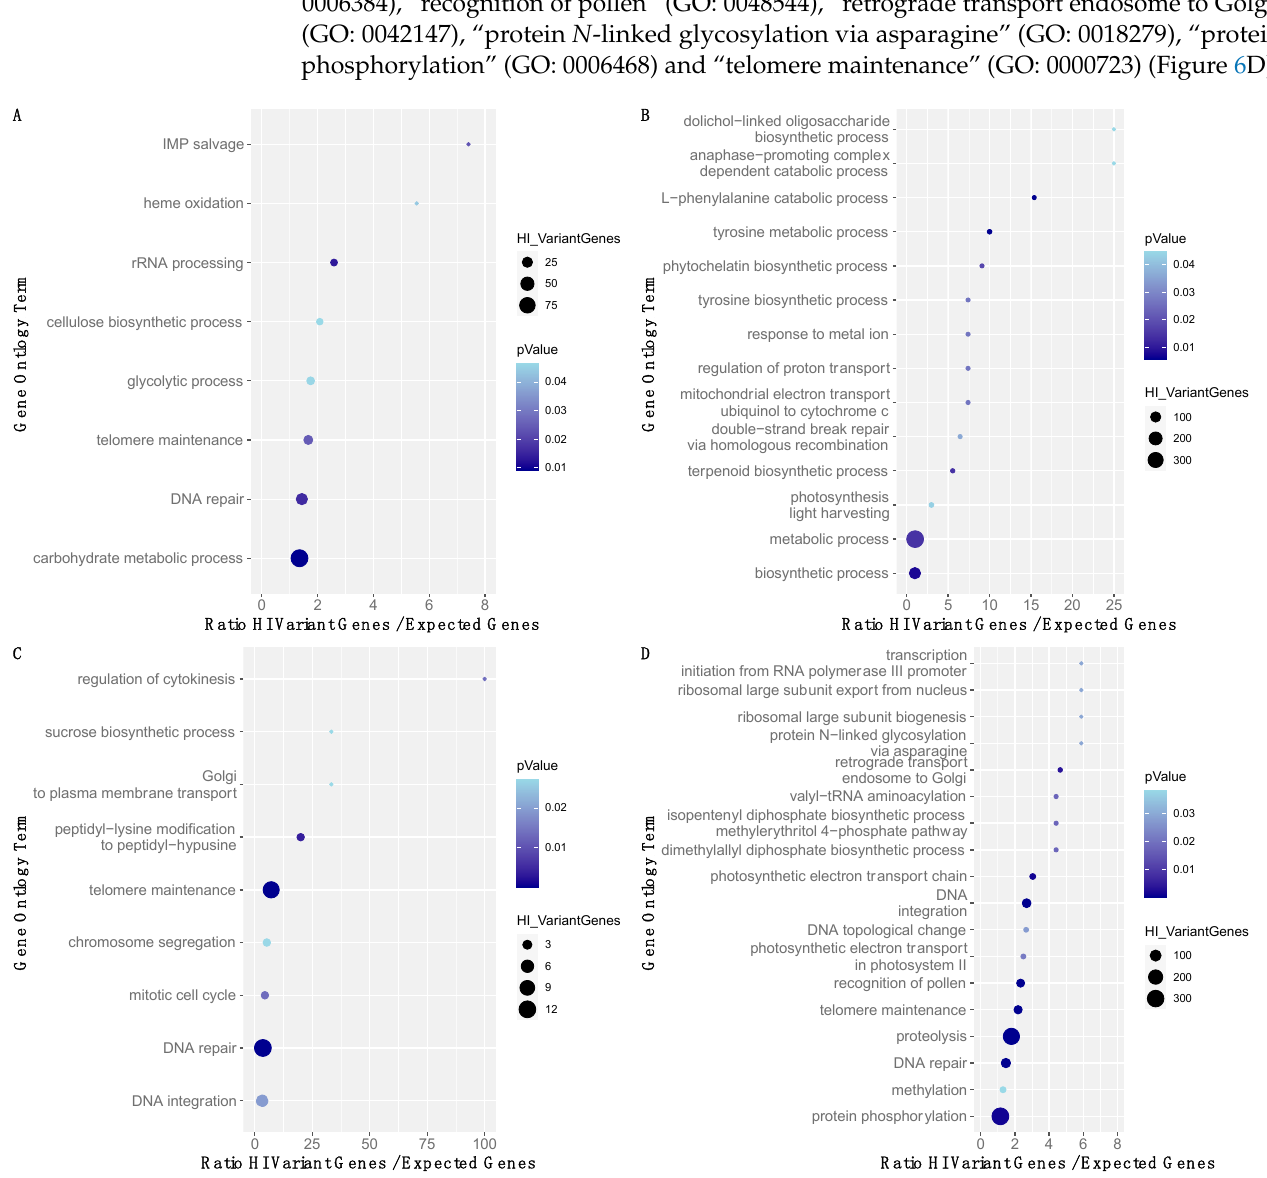
Figure 6. Gene Ontology analysis of the genes affected by high impact variants. The x-axis represents the value of the over or under-representation of these categories. The size of the dot represents the number of genes of the category and the color intensity its statistical significance as p -value. ( A ) Vouves bottom tree sample; ( B ) Vouves top tree sample; ( C ) High impact changes shared by all the Greek accessions (‘Kalamon’, ‘Koroneiki’, ‘Mastoidis’, ‘Mavreya’, ‘Megaritiki’ and ‘Myrtolia’) but absent in the Vouves tree; ( D ) Genes affected by high impact variants common for all the datasets (Vouves tree and Greek accessions).